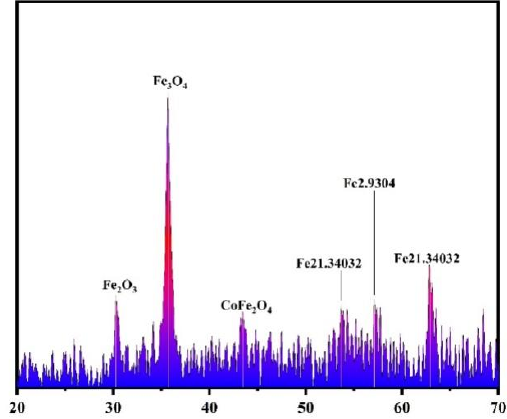
Figure 5. XRD analysis of Co-nZVI/GAC.